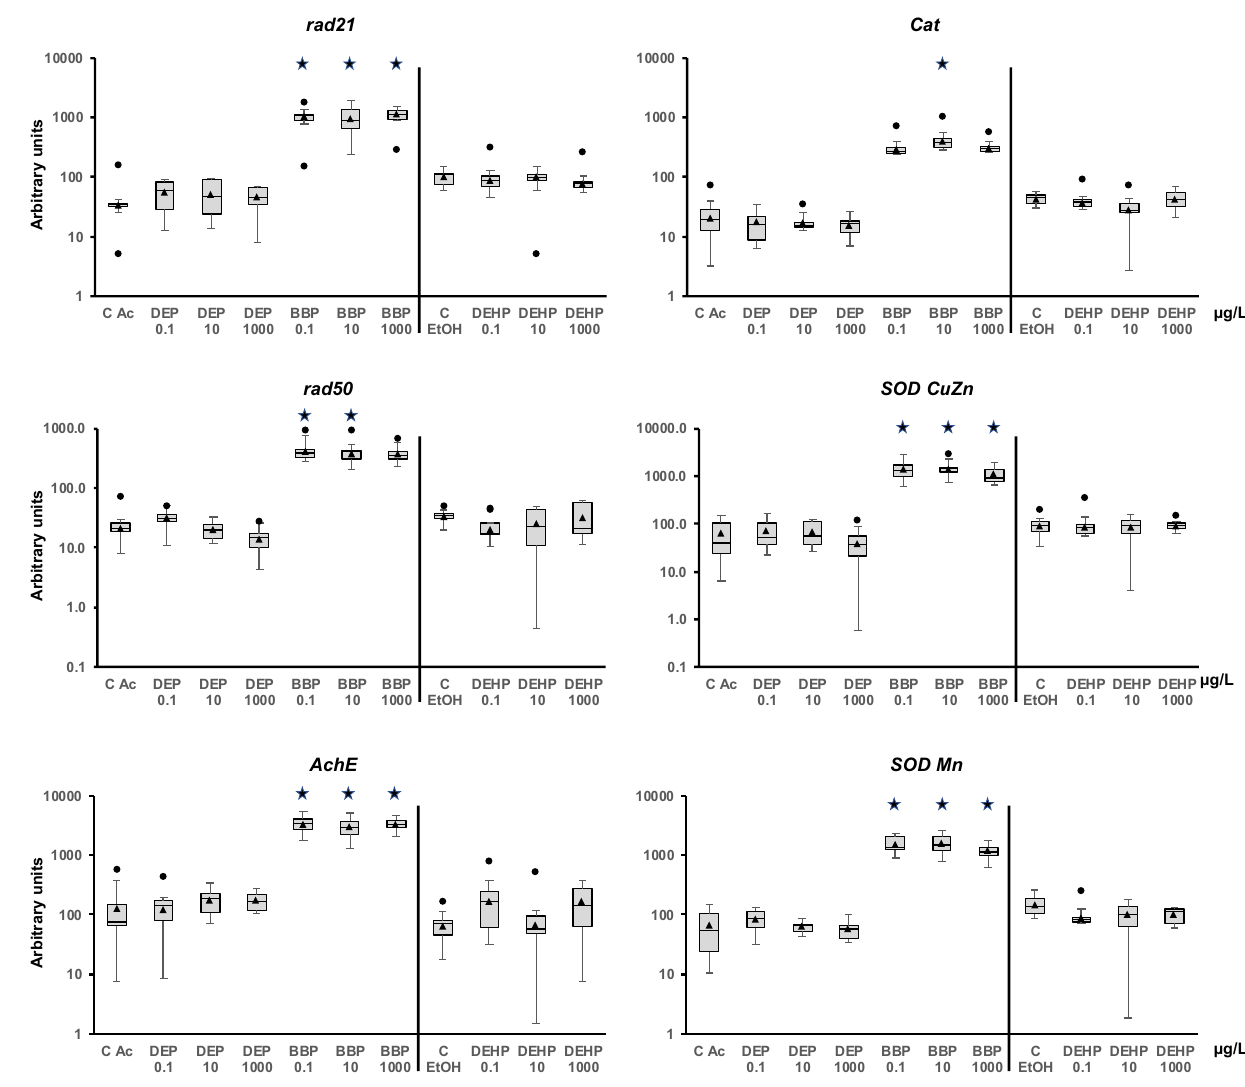
Figure 2. Transcript levels of DNA repairing mechanisms ( rad21 and rad50 ), nervous system ( AChE ), and oxidative stress ( Cat , SOD CuZn , and SOD Mn ) genes in Physella acuta adults after in vivo exposure to diethyl phthalate (DEP), benzyl butyl phthalate (BBP), and bis-(2-ethylhexyl) phthalate (DEHP) for 1 week at 19 °C. The mRNA levels were normalized using rpL10 , Act , PFKFB2 , and GAPDH as reference genes. The comparison was performed with the solvent-exposed (EtOH, acetone) controls. Whisker boxes are shown (n = 9 individuals per box). The median is indicated by the horizontal line within the box, and the 25th and 75th percentiles are indicated by the boundaries of the box. The highest and lowest results are represented by the whiskers. The small triangle inside the box denotes the mean, and the outliers are shown (circles). Significant differences to the respective controls (asterisk) are indicated ( p <